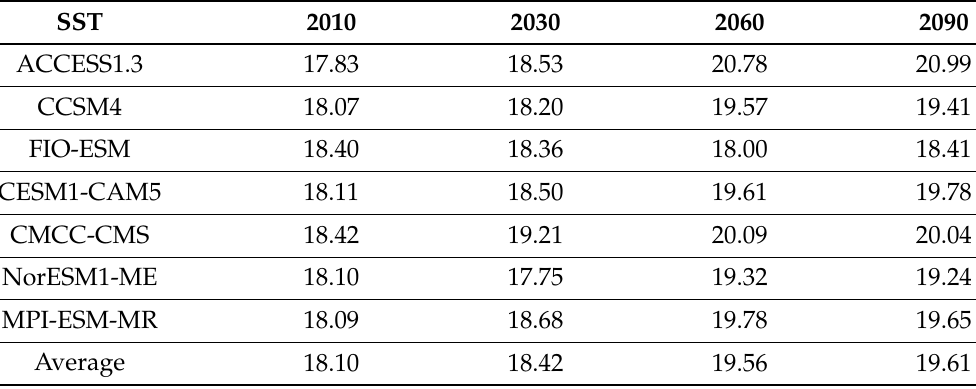
Figure 4. The decadal SST variations in the next 100 years. Table 3. The decadal SST variations in the next 100